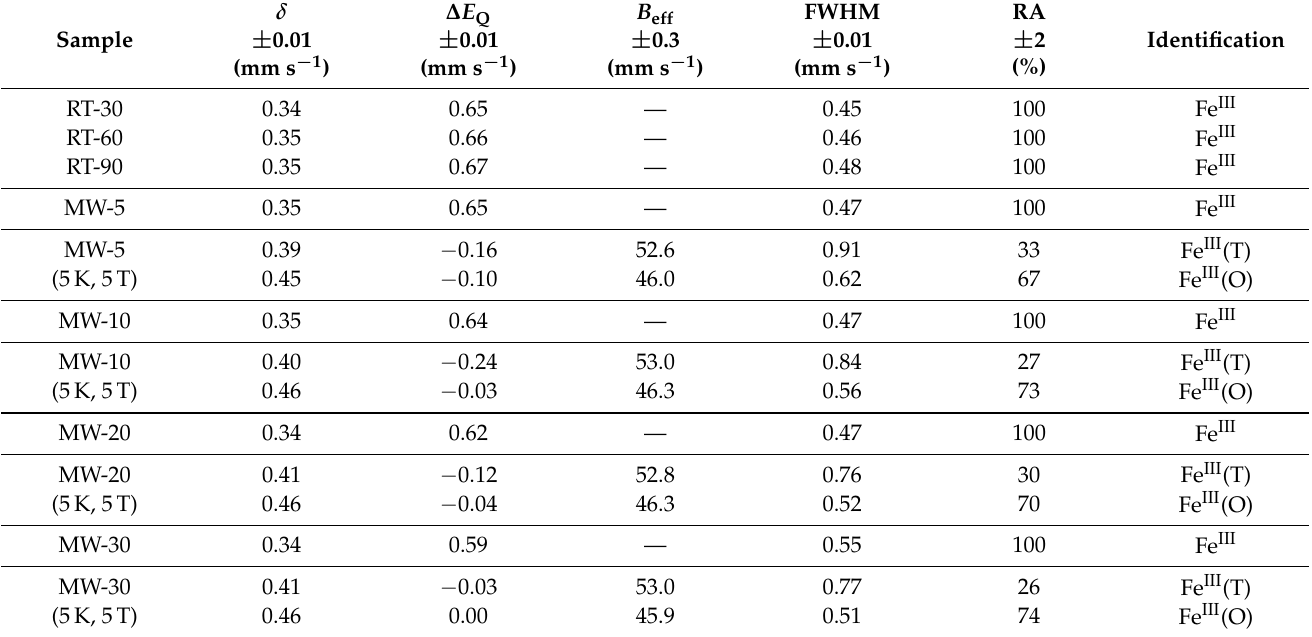
Figure 10. Calculated inversion factor of the MW series samples of zinc ferrite. Table 5. Components and parameters of room temperature Mössbauer spectra of prepared